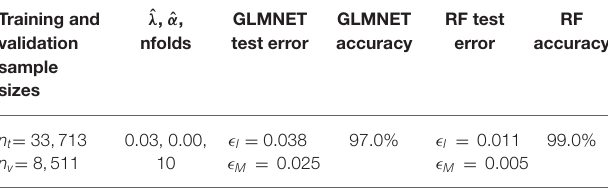
TABLE 3 | General Linear Mixed-elastic net (GLMNET) and Random Forest (RF) model specifications with the optimum λ and α values as well as the number of folds for validation.